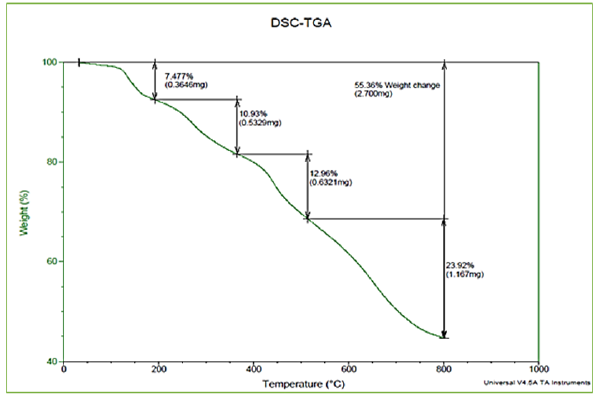
Fig. 6. TGA curve of palladium complex of 2-Amino 4-(phenyl) thiazole